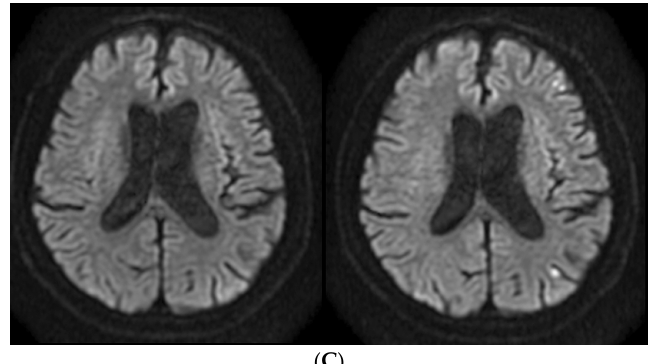
Figure 3. ( A ) Preoperative brain perfusion single-photon emission computed tomography in a 74-year-old man with symptomatic left internal carotid artery stenosis (90%) shows reduced cerebral blood flow ( left ) and reduced cerebrovascular reactivity to acetazolamide ( center ) in the left cerebral hemisphere where hyperperfusion develops immediately after surgery ( right ); ( B ) Transcranial Doppler recording during exposure of the carotid arteries in the patient of Figure 3A shows three microembolic signals ( arrows ) in the power spectrum display of left middle cerebral artery blood flow. This patient had a total of 10 microembolic signals during exposure of the carotid arteries; ( C ) A diffusion-weighted image 6 h after surgery in the patient of Figure 3A,B shows development of new postoperative multiple high-intensity lesions in the left cerebral hemisphere ( right ) when compared with a preoperative image ( left ). These lesions did not change on diffusion-weighted imaging 24 h after surgery. This patient suffered slight motor weakness in the right upper extremity after recovery from general anesthesia, and this deficit resolved completely within 12 h.